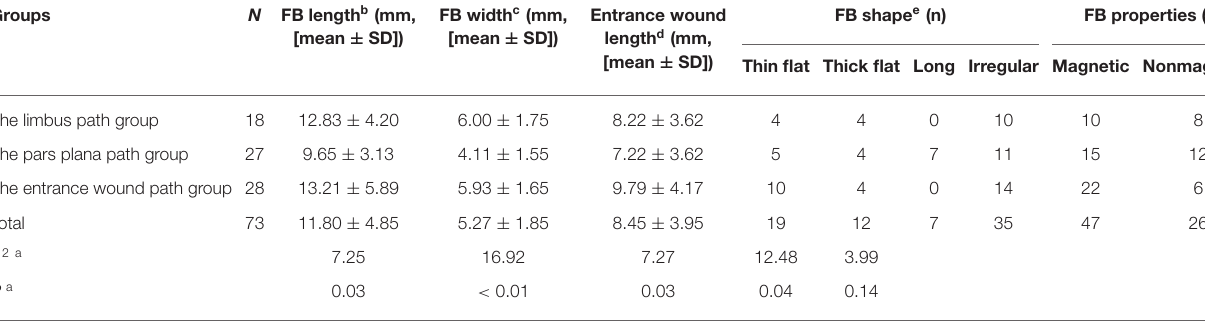
a Comparison between the three extraction path groups, Kruskal-Wallis H test for quantitative data, chi-square test for qualitative data; b pairwise comparison between the three IOFB extraction path groups, the IOFB length in the pars plana path group was shorter than that in the limbus path group and the entrance wound path group, respectively (z = − 2.59, P = 0.01; z = − 2.01, P = 0.04), no difference between the latter two groups (P > 0.05); c pairwise comparison between the three IOFB extraction path groups, the IOFB width in the pars plana path group was shorter than that in the limbus path group and the entrance wound path group, respectively (z = − 3.32, P < 0.01; z = − 3.65, P < 0.01), no difference between the latter two groups (P > 0.05); d pairwise comparison between the three IOFB extraction path groups, the entrance wound length in the pars plana path group was shorter than that in the entrance wound path group (z = − 2.80, P < 0.01), no difference was found between the other paired groups (P > 0.05); e Fisher’s exact probability test. After eliminating